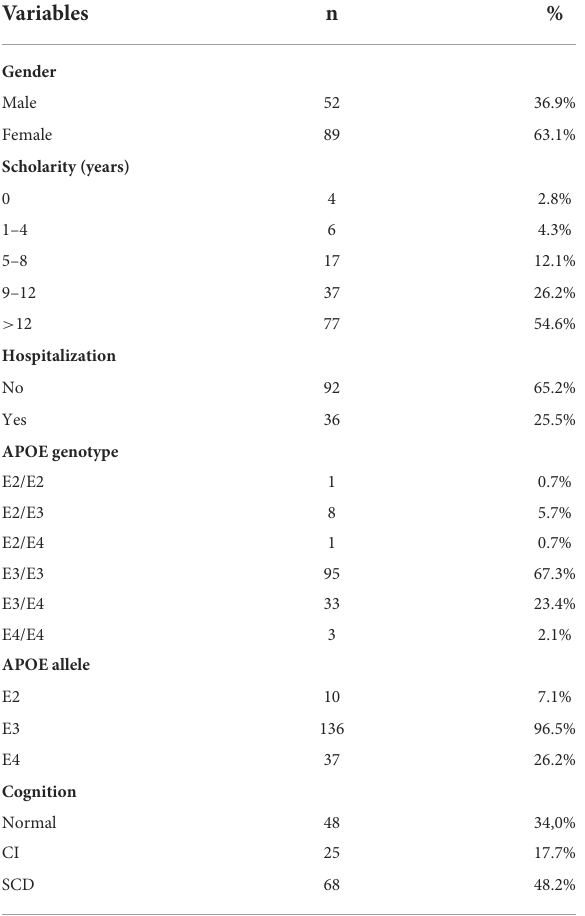
TABLE 1 Participant demographics, clinical characteristics, APOE genotype and cognition